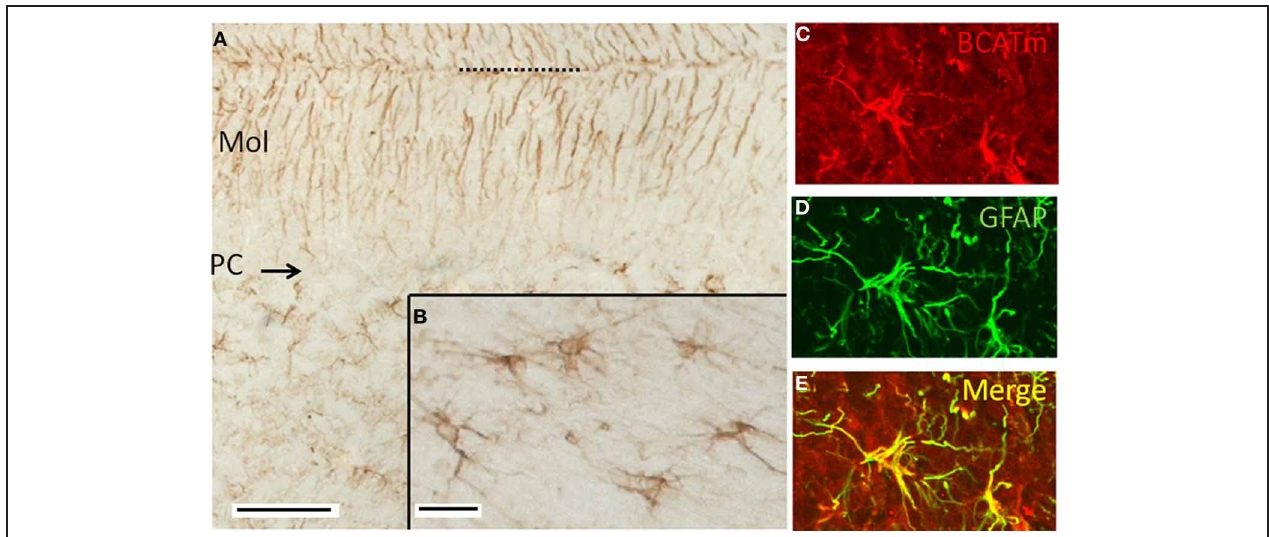
be astrocytes. (C) Rhodamine-immunolabel of BCATm in the cerebellar white matter. (D) FITC-immunolabel of GFAP in the same section as in panel C . (E) Merged image of panels C and D , demonstrating label of BCATm in several astrocytes. Scale bars: (A) 100 μ m, (B–E) 25 μ m.